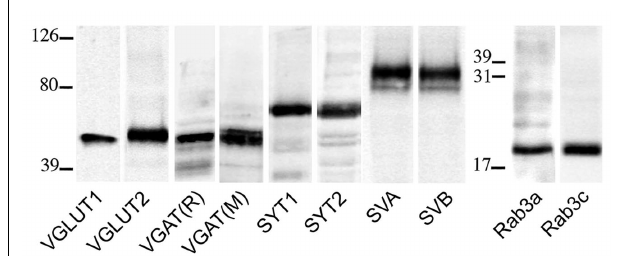
FIGURE 1 |VGLUT1,VGLUT2,VGAT (R, rabbit; M, mouse), SYT1, SYT2, SV2A, SV2B, Rab3a, and Rab3c antibodies recognized bands of ∼ 55, 60, 57, 65, 65, 100, 95, 25, and 25kDa in the order, in crude membrane fractions of rat cerebral cortex.